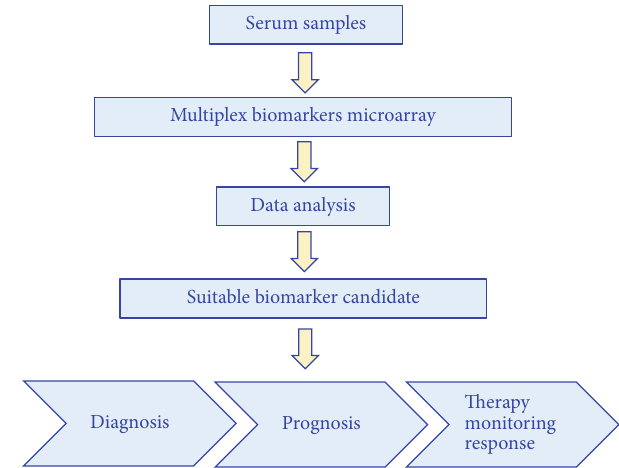
Figure 1: Flowchart related to a broad-spectrum bead-based multiplex